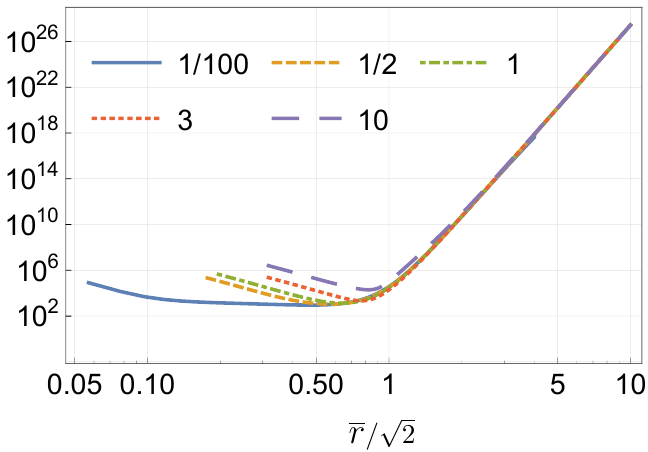
Figure 12. Square of the Ricci tensor, Ric 2 = R mn R mn , for several zero-temperature solutions with di(cid:11)erent charge